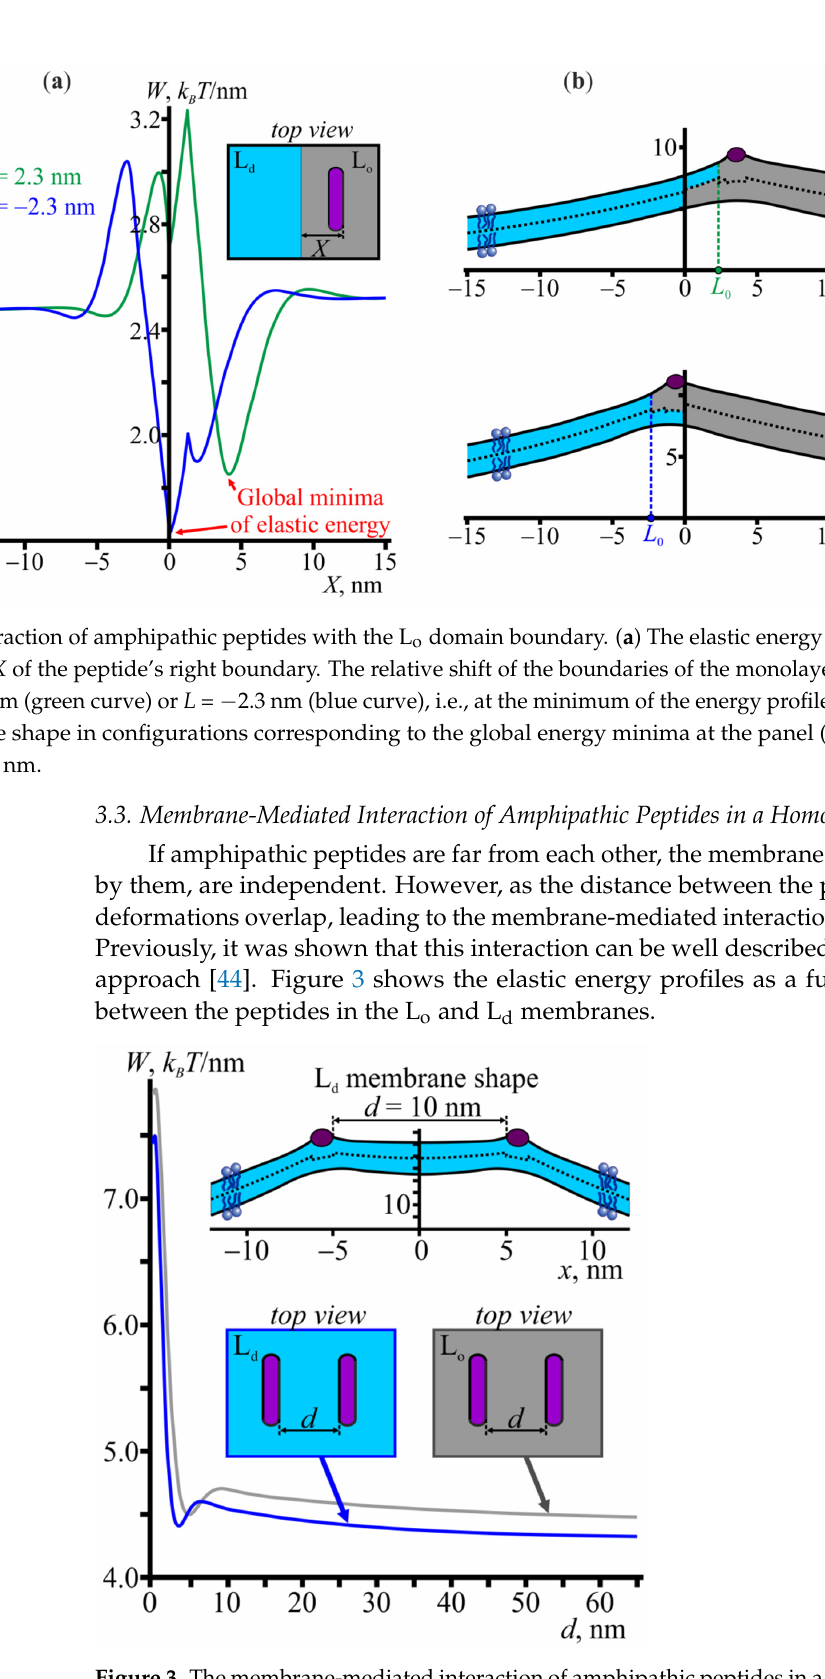
Figure 3. The membrane-mediated interaction of amphipathic peptides in a homogeneous membrane. Elastic energy profile as a function of the distance between the peptides in L o (grey curve) and L d (blue curve) membranes. The inset at the top of the figure shows the L d membrane shape at a distance d = 10 nm between the peptides.